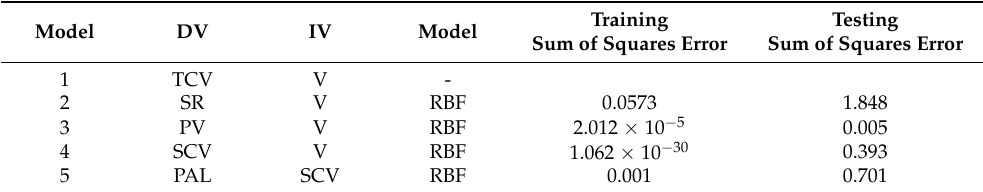
Table 7. Prediction models based on artificial neural networks.